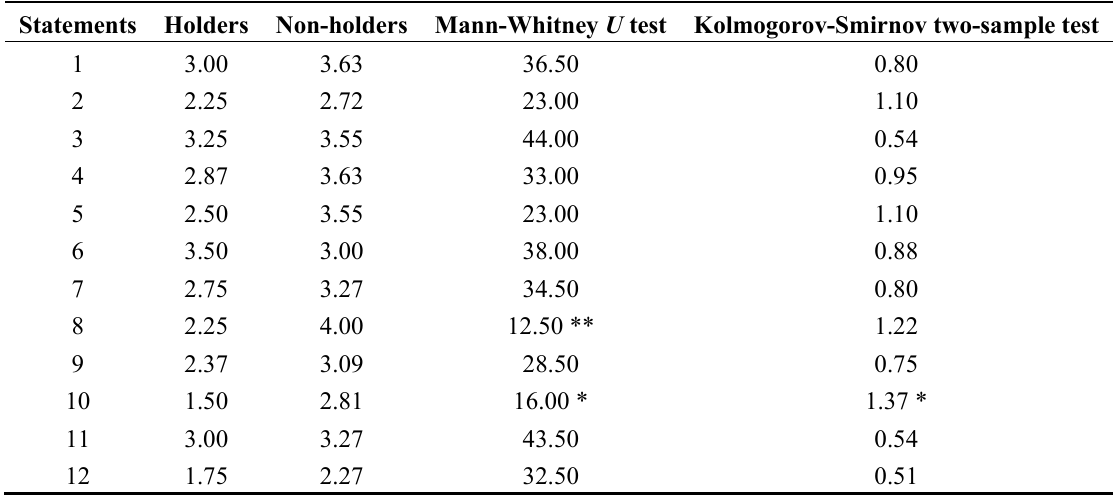
Table 5. Statistical analysis of responses, comparing holders and non-holders of water rights.